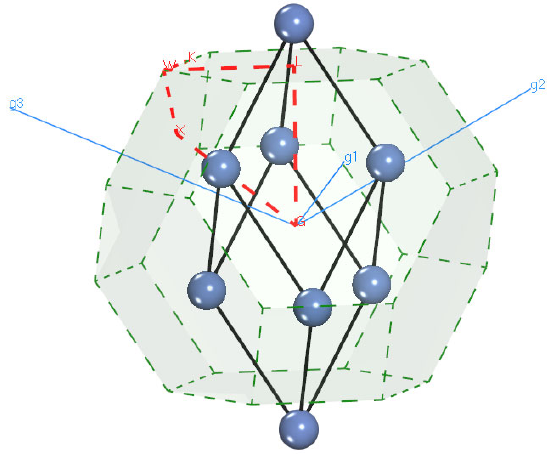
Figure 1. Primitive cell of Cu–Ni; the blue atom corresponds to Cu and Ni; the contents of atom are Cu 0.5 Ni 0.5 , Ni 0.92 Cu 0.08 , and Cu 0.95 Ni 0.05 . Red line and point refer to integration path and k-point in Brillouin zone. g (cid:4652)⃗ 1 , g (cid:4652)⃗ 2 , g (cid:4652)⃗ 3 are reciprocal vector. Table 1. Optimized lattice parameter for Cu–Ni alloys with experiments [2,9,10]. Composition